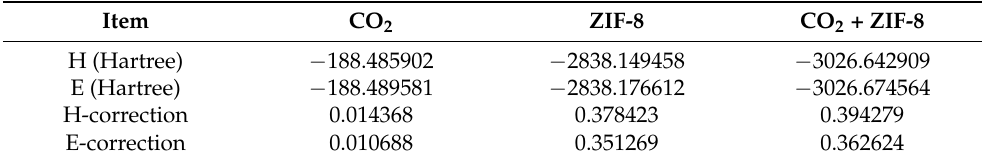
Table 2. Simulated energies of the CO 2 adsorbed by